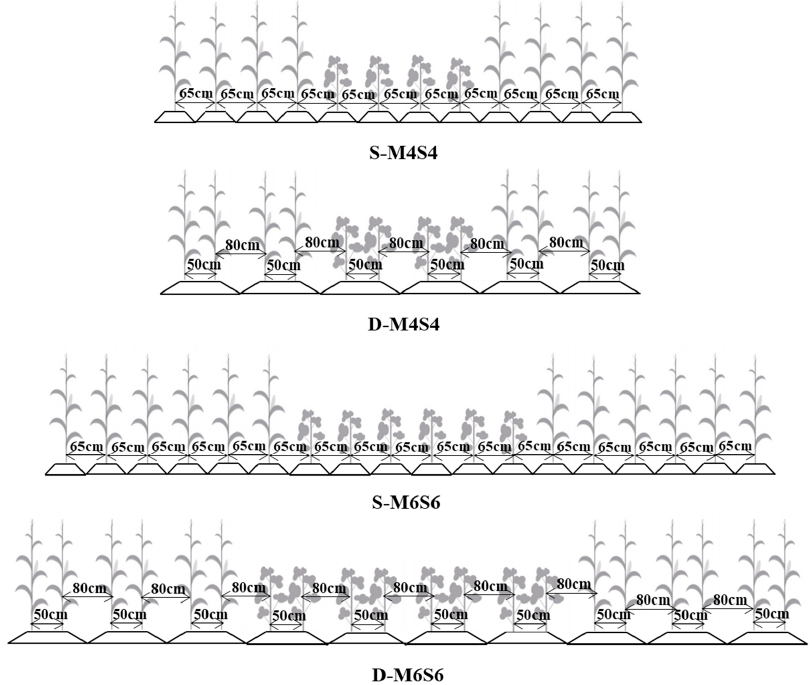
Figure 2. Diagrammatic sketches of different planting patterns (S: uniform-ridge pattern, spacing is 65 cm; D: wide–narrow-row pattern, wide row is 80 cm, and narrow row is 50 cm; M4S4: